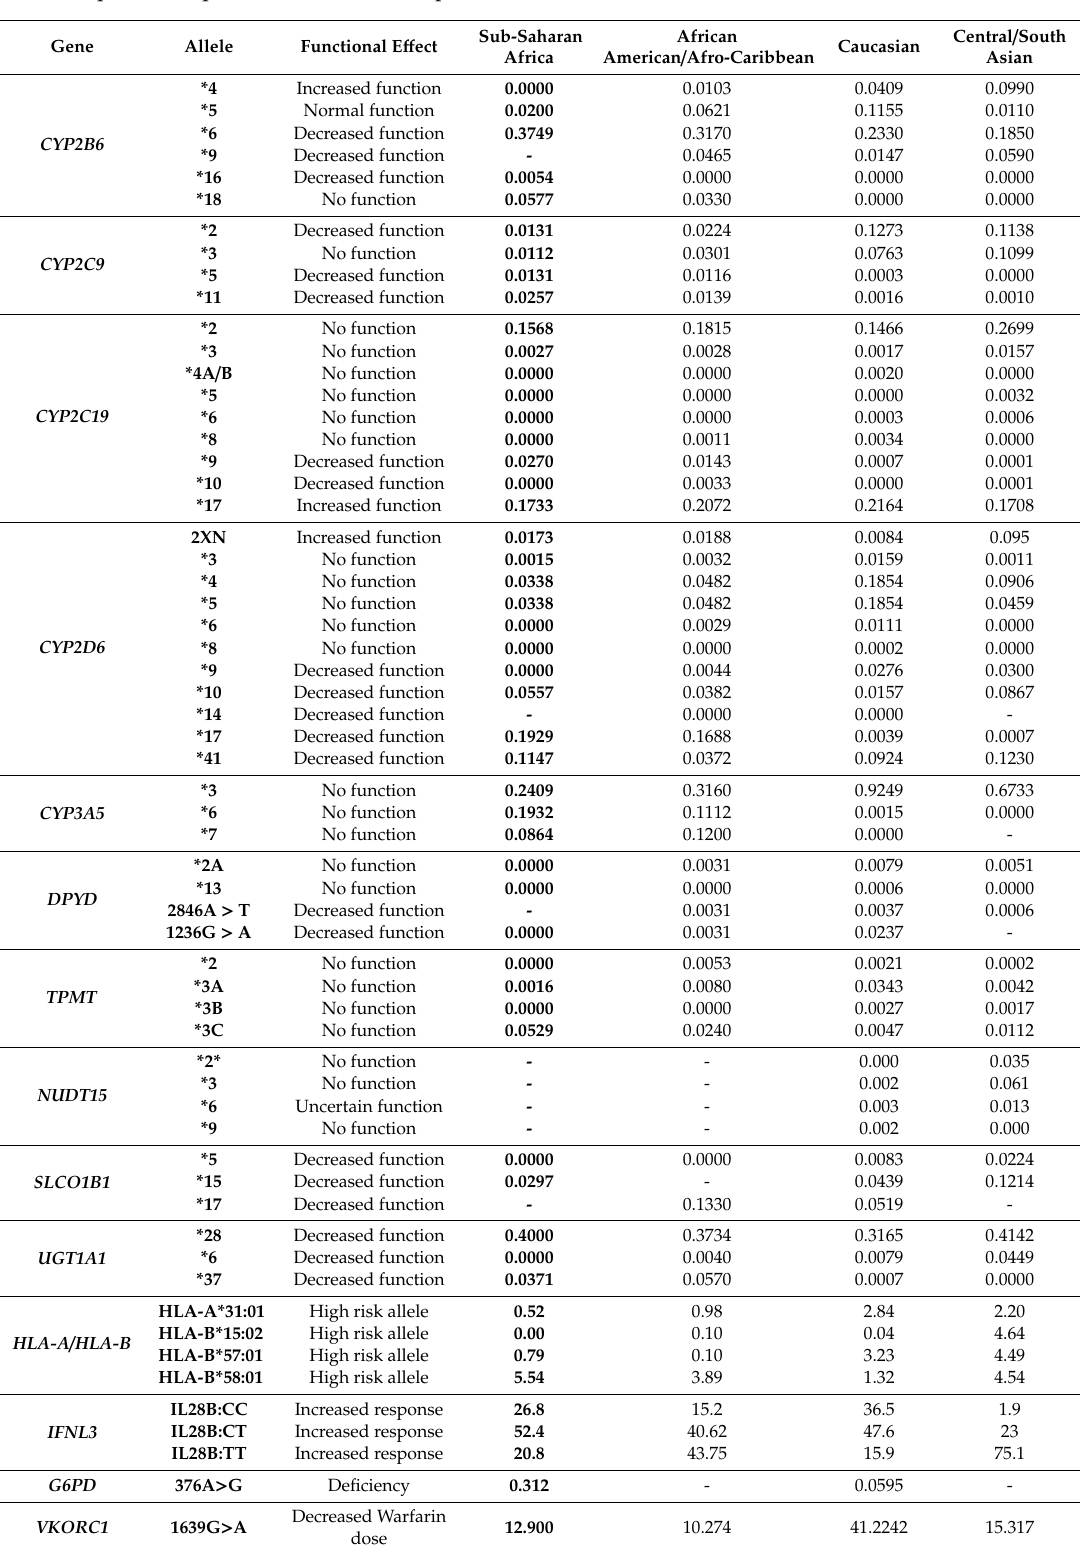
Table 2. Average frequencies (%) of alleles (* star alleles) with “actionable variants” in pharmacogenes as assigned by CPIC in major global biogeographical populations. Average frequencies are based on the reported frequencies in one or multiple studies